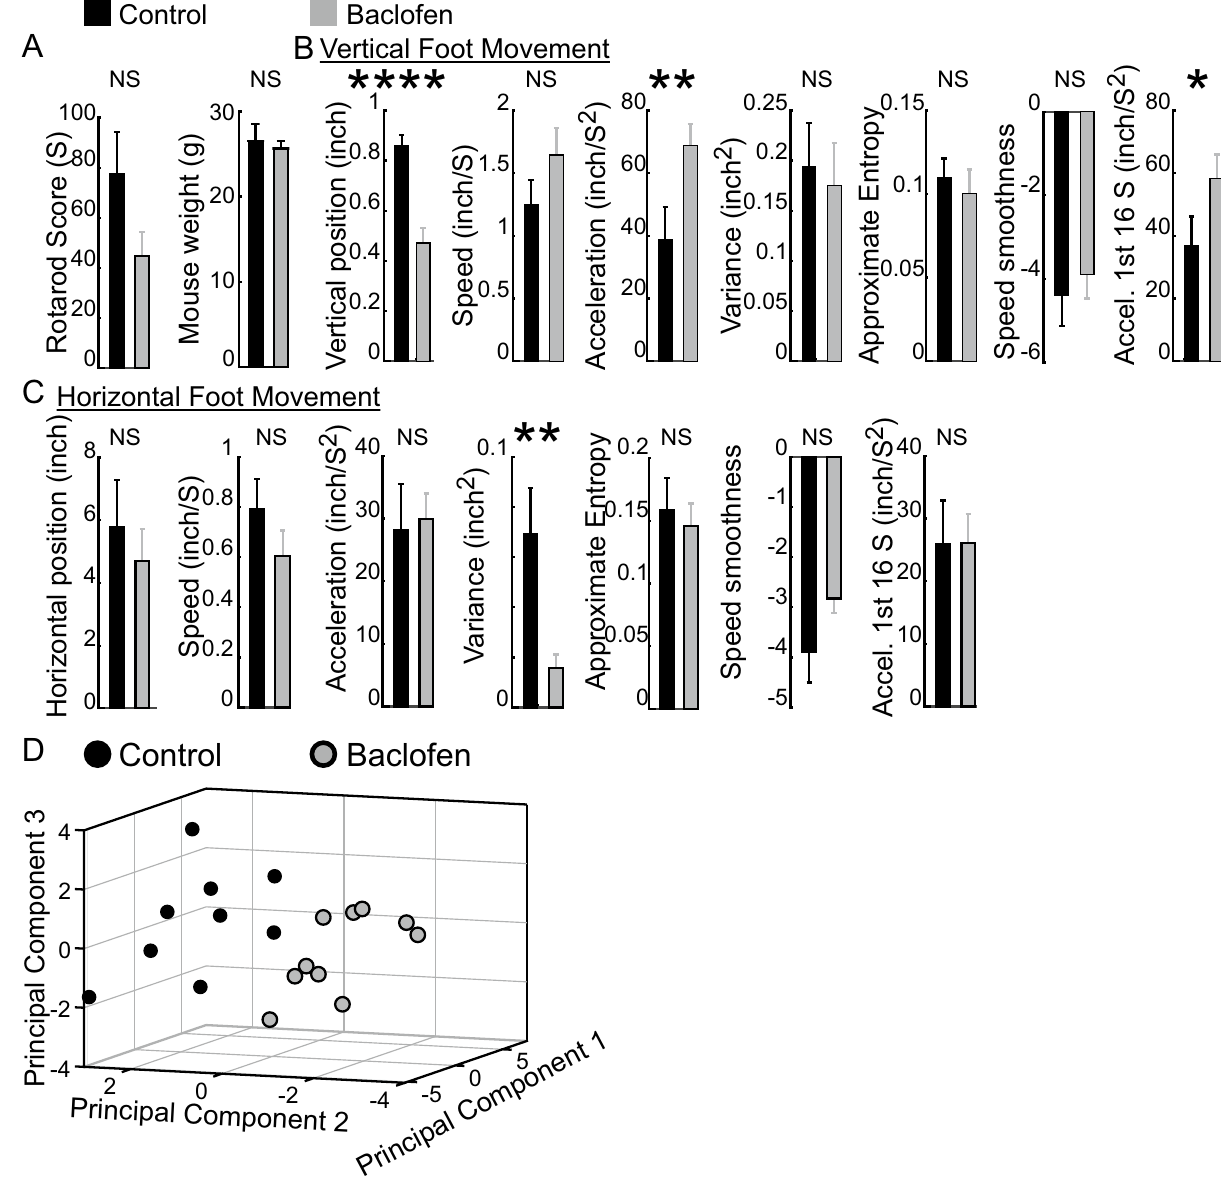
Figure 9. Impact of baclofen on first trial features. ( A – C ) Rotarod score and mouse weight ( A ) and vertical height and horizontal ( B , C ) intra-session first trial features in control (n = 9) and baclofen-injected mice (n = 10). Bar charts illustrate means; error bars represent S.E.M for rotarod score and intra-session features for right hind-limb paw position. Significant changes in some intra-session features are notable despite lack of change in rotarod scores. ( D ) Scores derived from principal component analysis (PCA) reveals distinct distributions ( p < 0.0001, MANOVA-Wilks test) for baclofen-injected (n = 10) and control mice (n = 9). Each dot represents one mouse. Values along an axis represent PCA scores for that principal component. A mouse can be represented in multi-dimensional space with each intra-session feature comprising one dimension. Dimensionality reduction with PCA reveals separate groups. * = p < 0.05; ** = p < 0.01; **** = p < 0.0001, (unpaired Student’s t